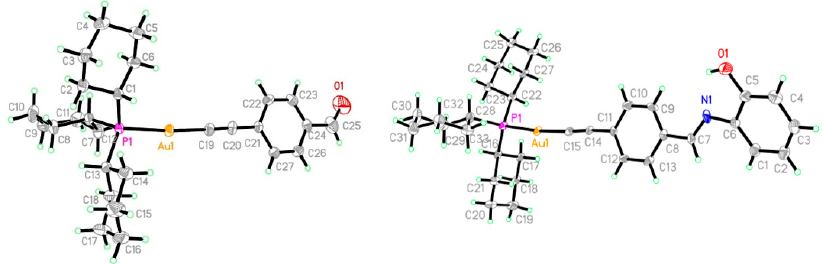
Figure 4. The changes in the IR spectra upon reacting 2 with 2-aminophenol to produce 5. Table 1. Bond lengths (Å) for complexes 2 and 5.